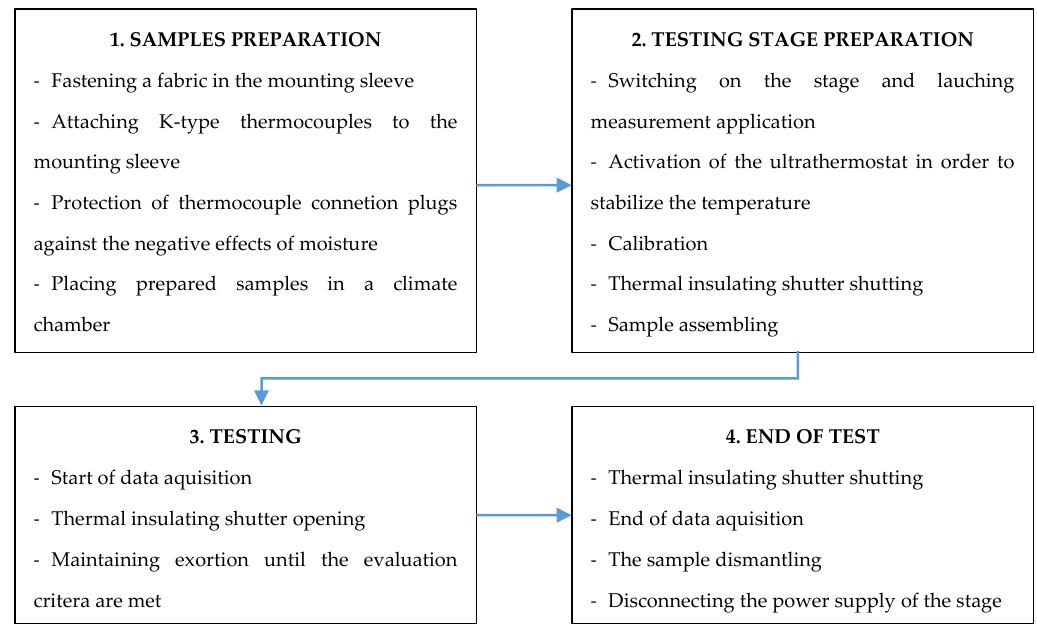
Figure 14. Scheme of testing methodology.